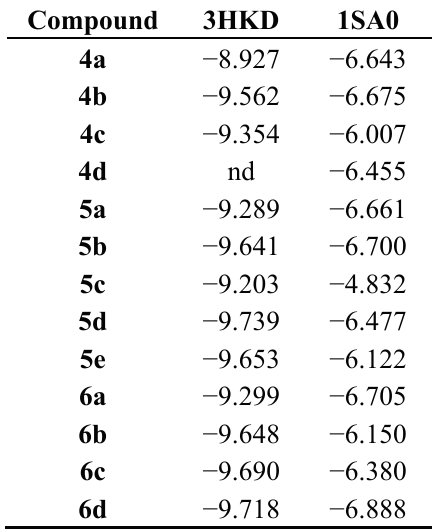
Table 1. Derivatives 4a – d , 5a – e and 6a – d docking scores for 3HKD and